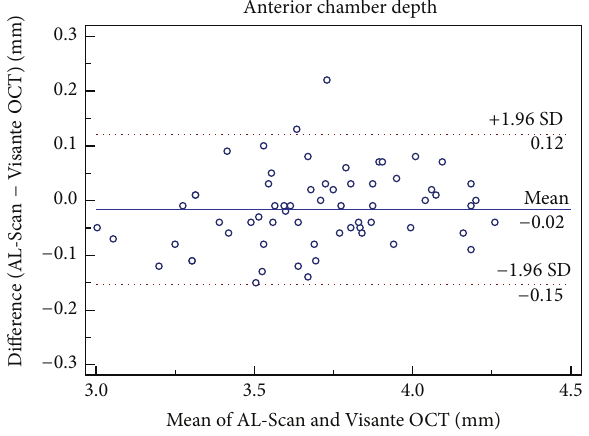
Figure 2: Difference in anterior chamber depth measurements between AL-Scan optical biometer and Pentacam rotating Scheimp- flug imaging device against their mean values. The solid line indi- cates the mean difference, and 95% limits of agreement are indicated by solid and dotted lines, respectively.